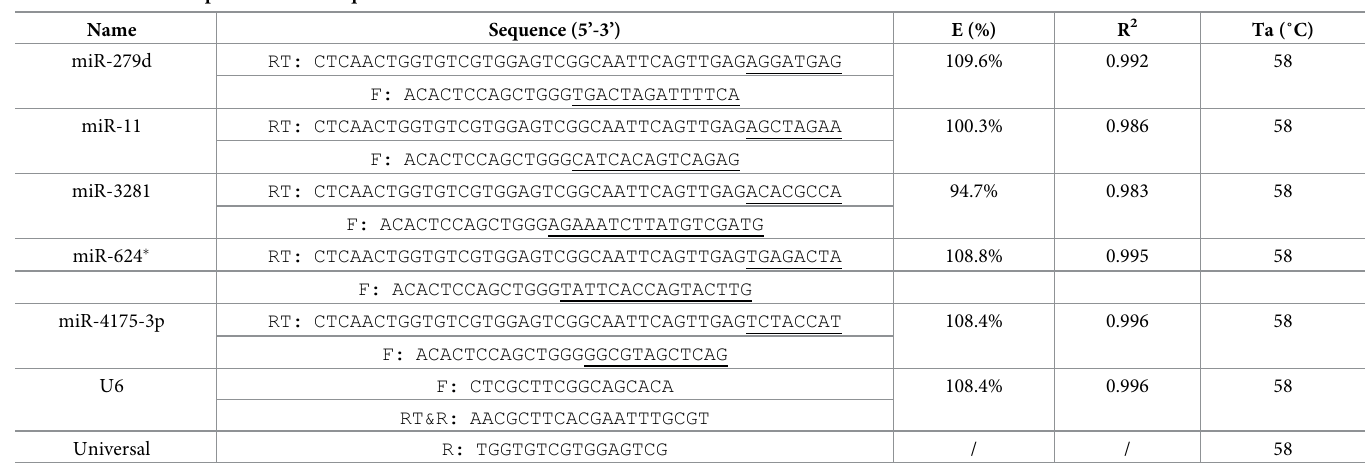
Table 1. Evaluation of primers used for